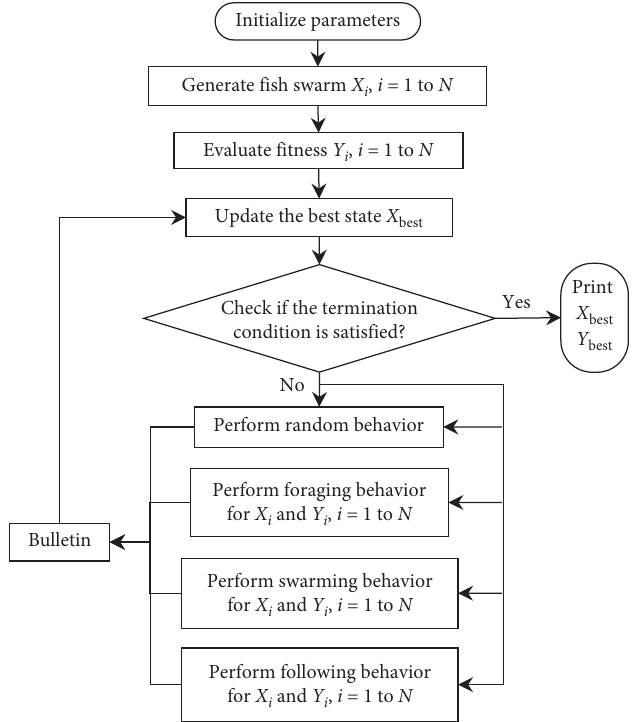
Figure 1: Flow chart of